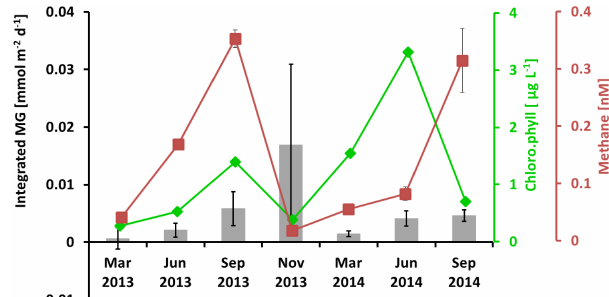
Figure 9. Temporal development of integrated net surface methano- genesis (0–5cmb.s.f.) in the sediment and chlorophyll (green) and methane concentrations (orange) in the bottom water (25m). Methanogenesis (MG) rates and methane concentrations are shown in means (from triplicates) with standard